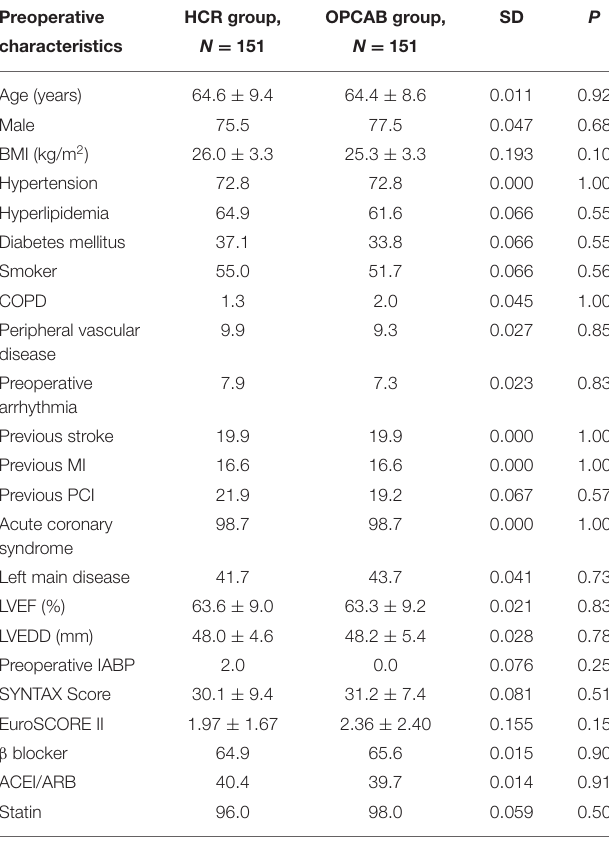
TABLE 1 | Preoperative characteristics of unmatched patients who underwent hybrid coronary revascularization (HCR) and off-pump coronary artery bypass (OPCAB).